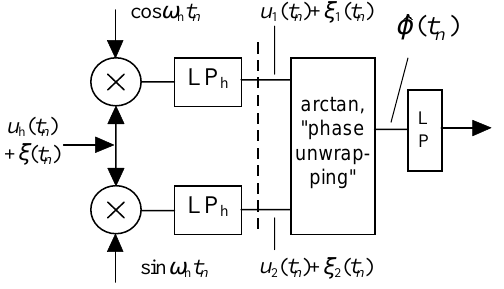
Fig. 3. Coherent demodulation scheme. The left side applies only to heterodyne interferometry. tion scheme are represented as discrete-time signal at t n , n = 0 , 1 , 2 , . . . , superposed by an additive noise process ξ ( t n ) , i.e. the quantization noise samples of the preceding A/D conversion are thought of as an ad- ditive noise signal. The left side of the demodulation scheme is related to the generation of quadrature sig- nals by digital signal processing. For quadrature sig- nals generated by optical means, only the right side of the scheme is valid. Applying an arctangent subroutine to the base-band quadrature signals and using a phase unwrapping procedure, we obtain an estimate of the phase sequence